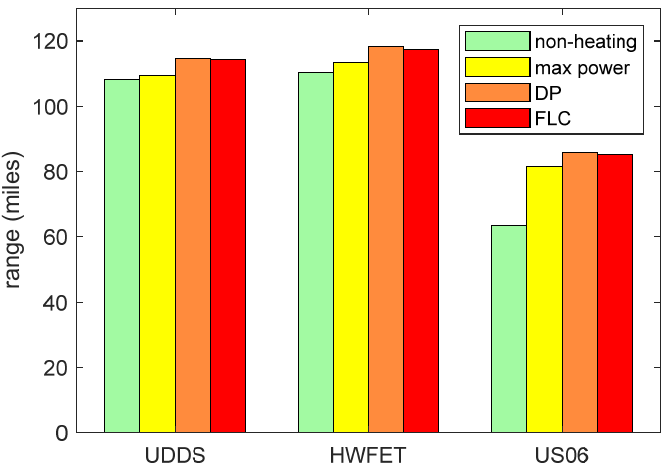
− 10 ◦ C and initial SOE of